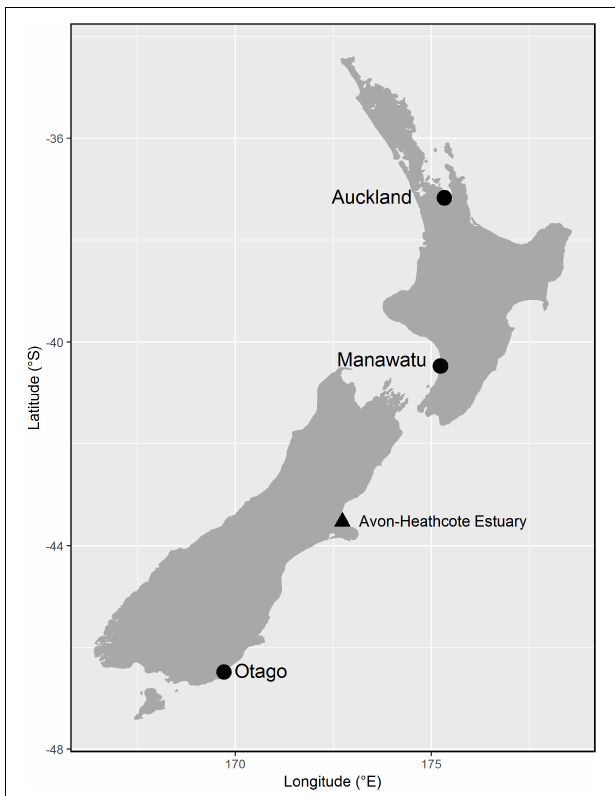
FIGURE 1 | Map of New Zealand showing the main study sites (circles), and another site where counts during the departure period were available from one year (triangle). Distances between the study sites are approximately 365 km between Auckland and the Manawatu Estuary and 800 km between the Manawatu and Otago